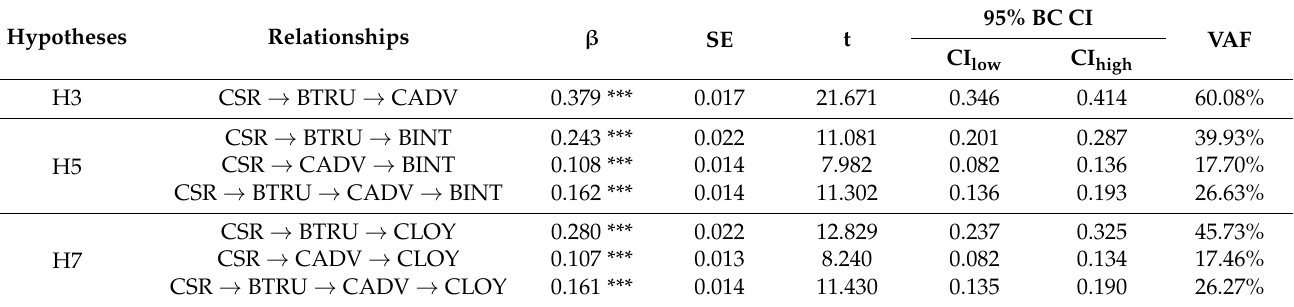
Table 7. Testing for indirect